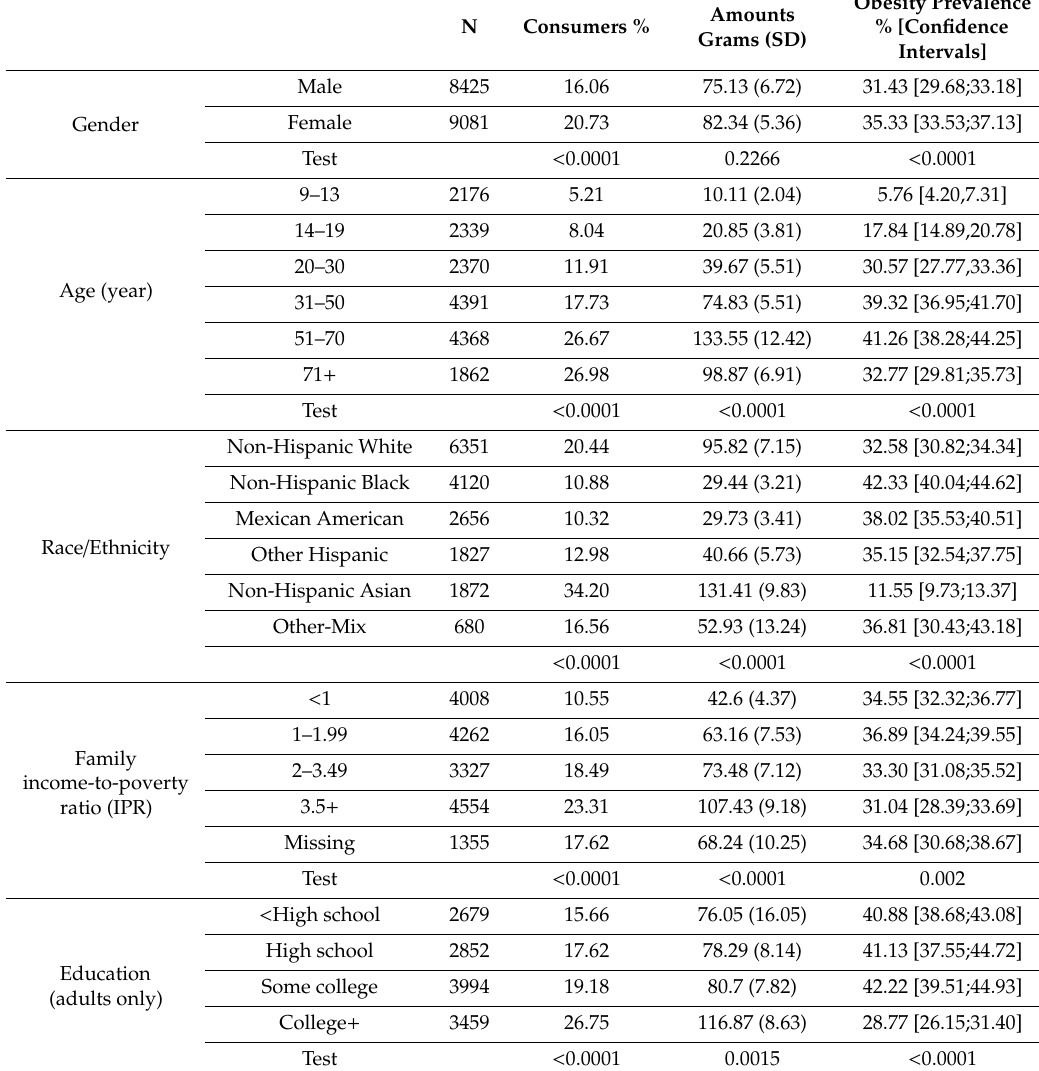
Table 1. Tea consumers (%), amounts consumed (grams and SD), and obesity prevalence (% and CI) by